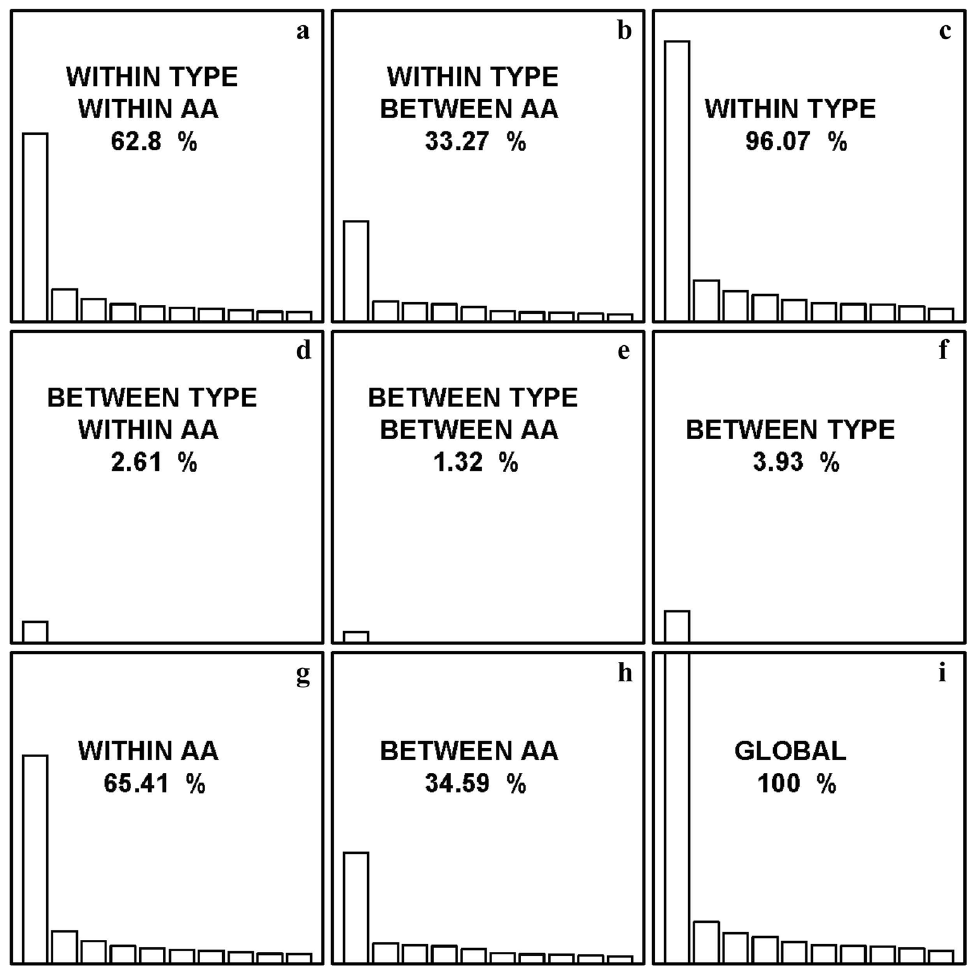
Fig. 1 Internal correspondence analysis of single-exon genes and multiple-exon genes in rice. The total codon usage variability is decomposed into the synonymous codon usage (within-AA) variability ( a , d , g ), amino acid usage (between-AA) variability ( b , e , h ), and variability of within ( a , b , c ) and between gene types ( d , e , f ). The performance of ICA yields nine elementary analyses ( a–i ). In each peculiar analysis, the contribution to the total codon usage variation is indicated, where only the first 10 eigenvalues are represented for